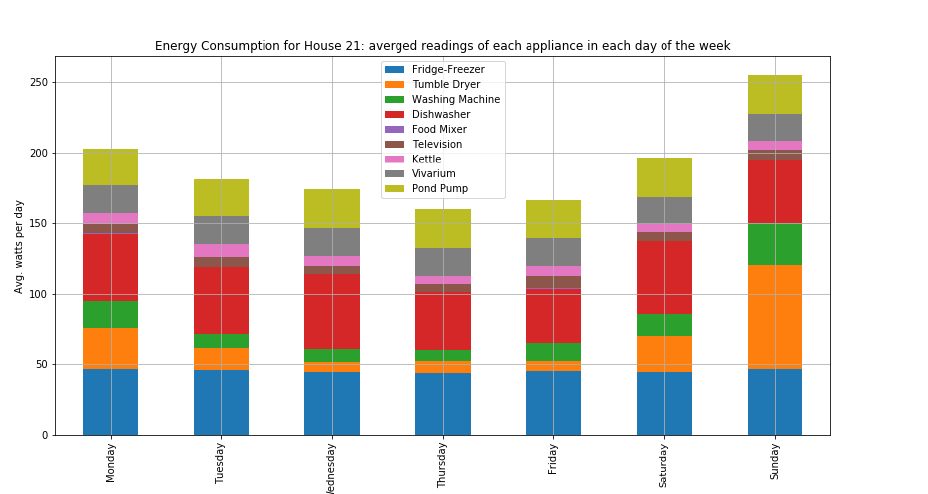
Figure A9. The average consumption per day of home appliances for house 21 with four